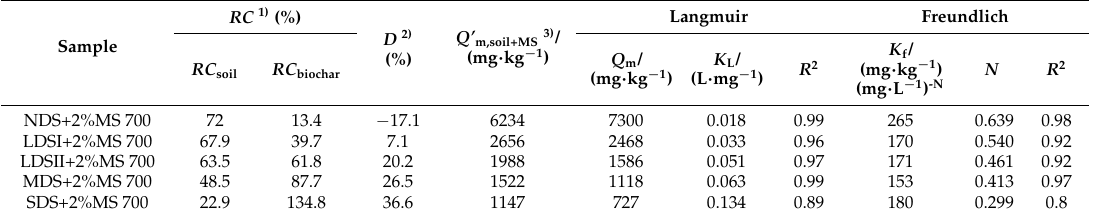
Figure 10. The relationship between the adsorption decline level ( D ) of Cd and the TOC of soil. Table 7. The regression parameters of Langmuir and Freundlich model fittings for adsorption isotherms and calculated values for Cd on soils amended with 2.0% MS700.